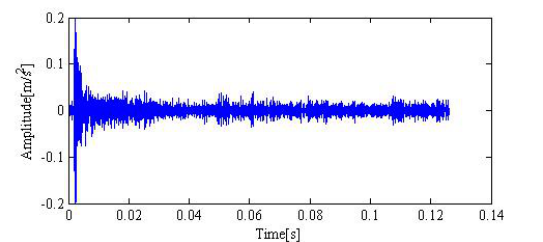
Fig. 3. Time domain waveforms of none